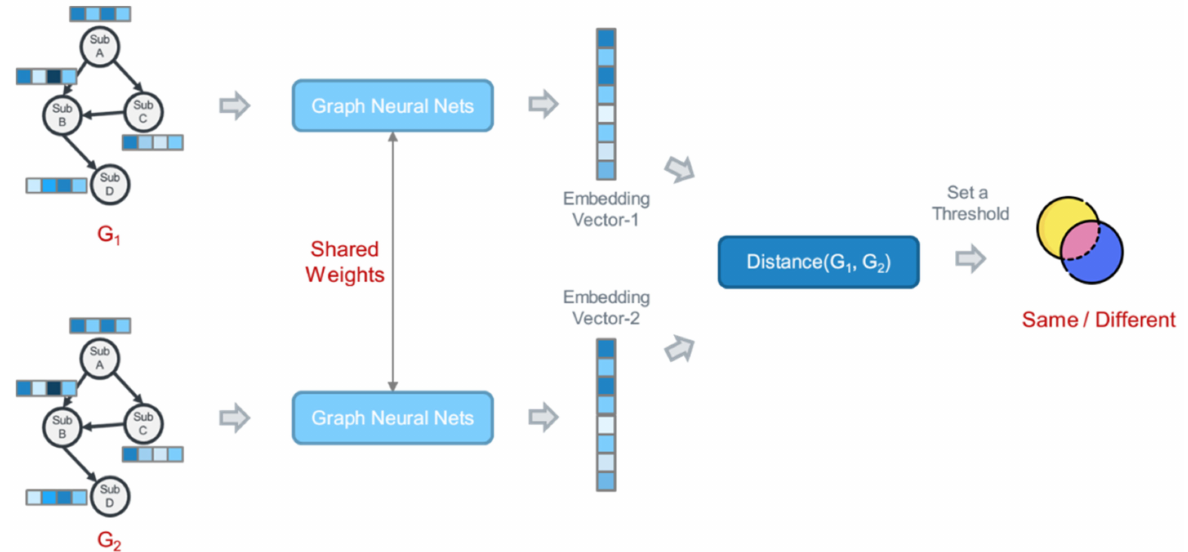
Figure 9. Applied similarity model